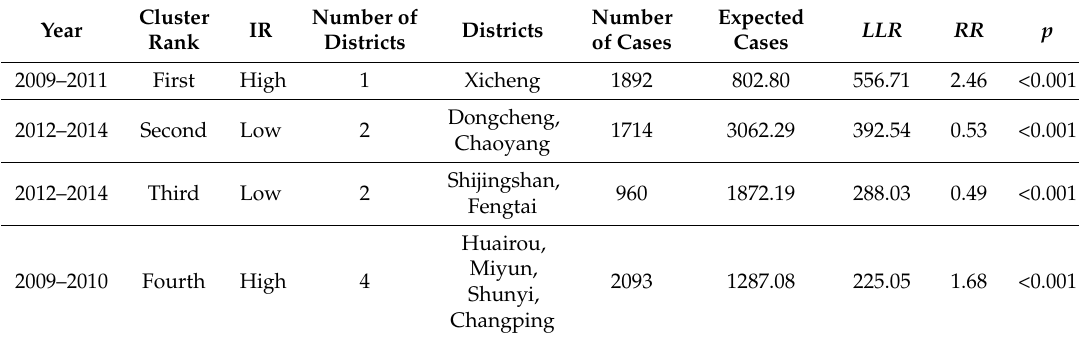
Table 3. Space-time scan statistics analysis of high and low IRs from 2009 to